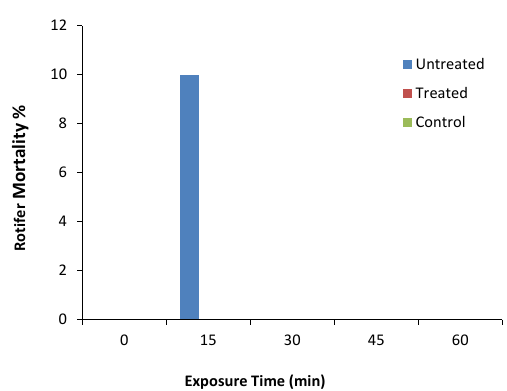
Fig. 11. Toxicity of the raw and ozonated solutions at different exposure time (Dye concentration = 100 mg/l, O mg/h, treated volume = 200 ml, ozonation time = 180 min, pH =